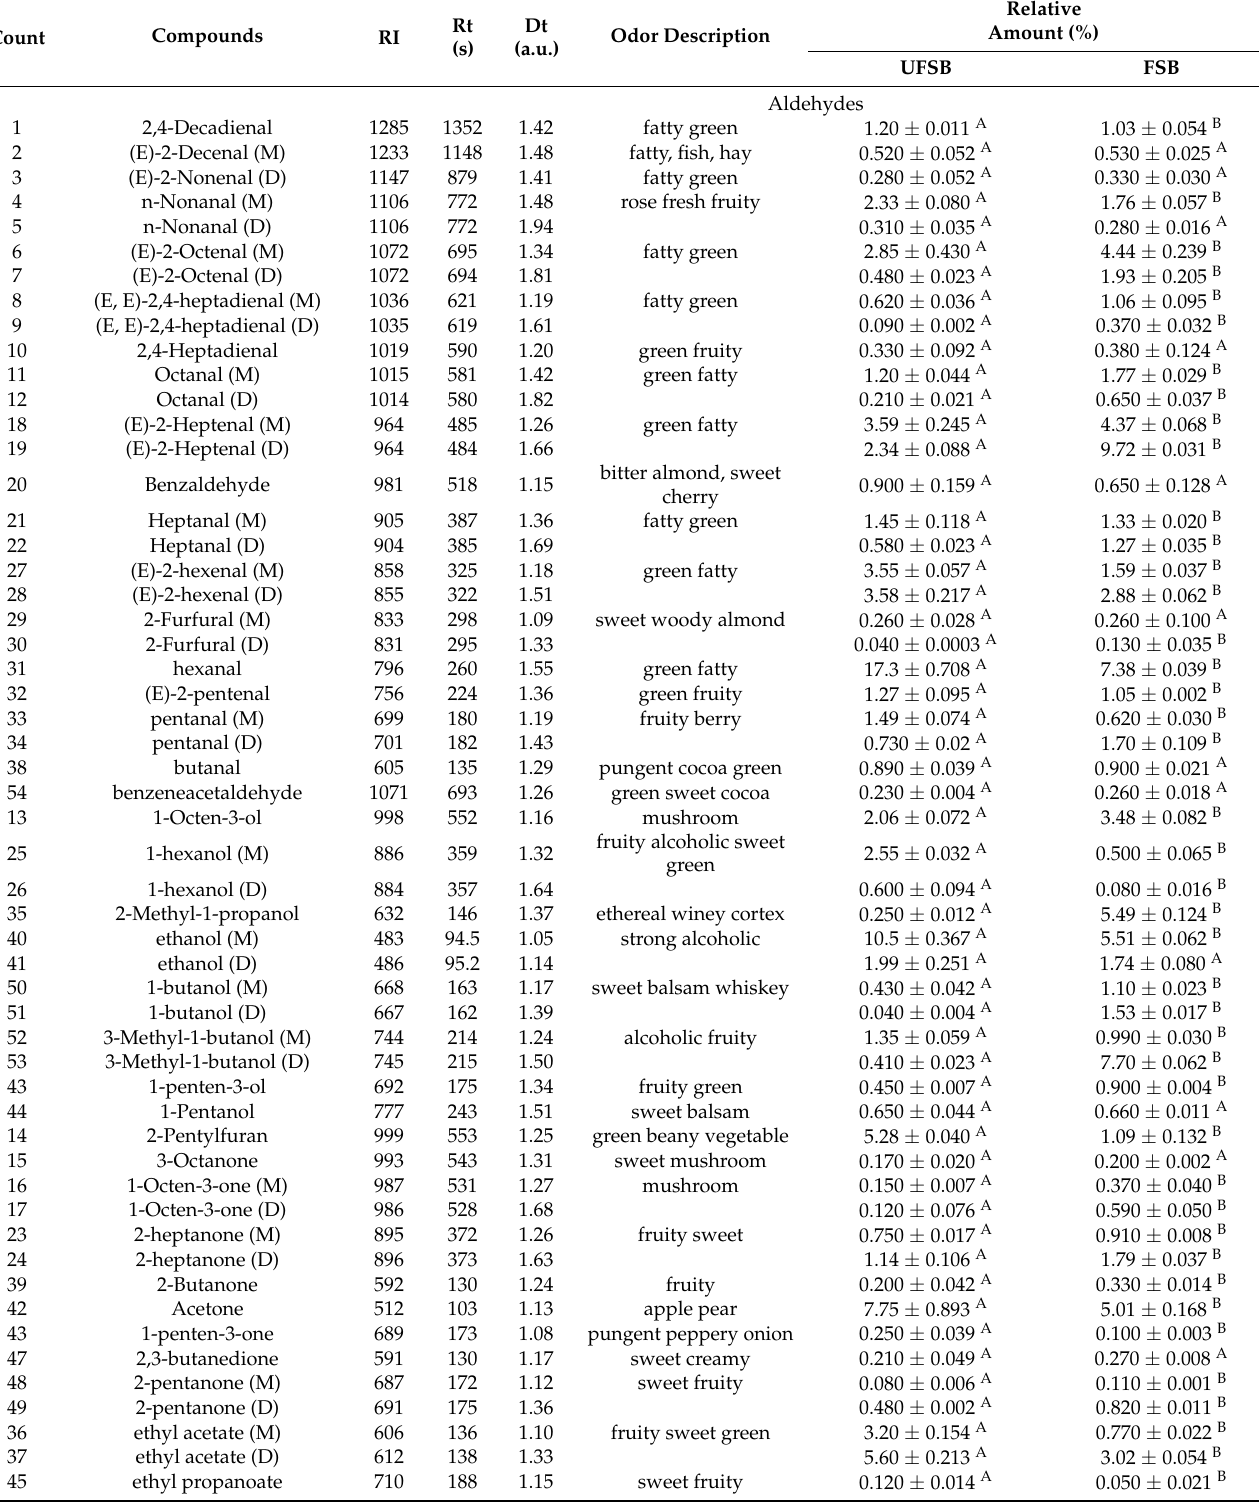
Table 2. Identification of the volatile compounds in fermented soy beverage by